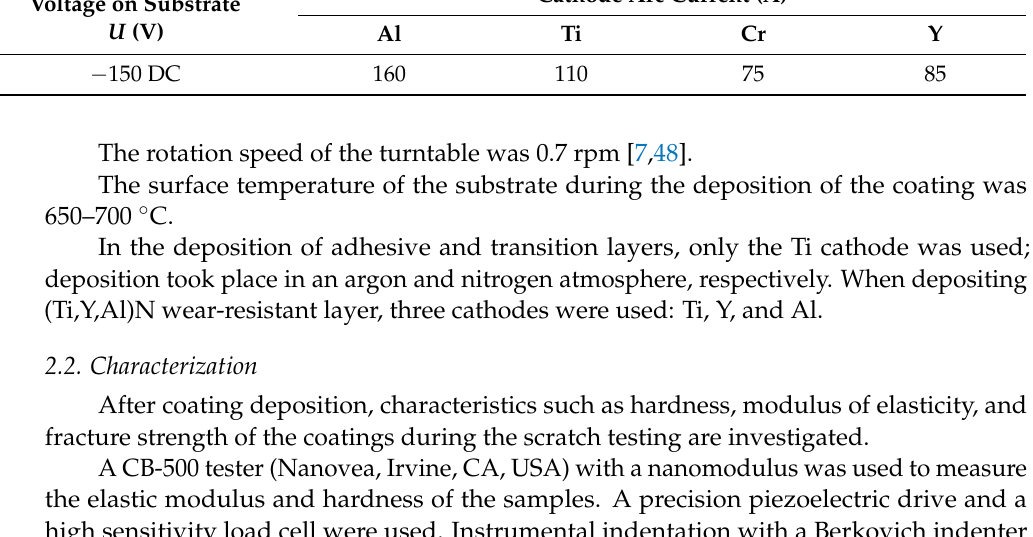
Table 1. Main parameters of the coating deposition process. Nitrogen